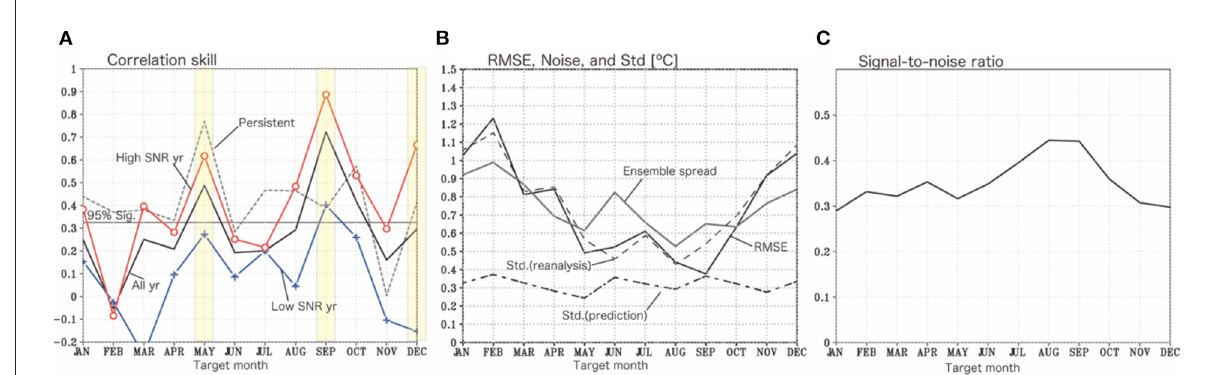
FIGURE1 (A) Correlation skills for 1-month lead prediction (e.g., prediction of December issued on 1st − 9th of November) of monthly temperature regionally averaged over most part of Japan (129 ◦ E − 141 ◦ E, 30 ◦ N − 37 ◦ N) for each calendar month. Correlation skills for all years of 1983–2020 (black), for years when the SNR is larger than its 1983–2020 mean (red), and for the other years (blue) are shown. Persistent skills (e.g., lag auto-correlation of December with previous November) are shown by a gray line. (B) RMSE (black line), ensemble spread (grey line), standard deviations of the reanalysis (dashed line) and the ensemble mean prediction (long and short dashed line) for each calendar month ( ◦ C). (C) 1983–2020 mean of SNR for each calendar